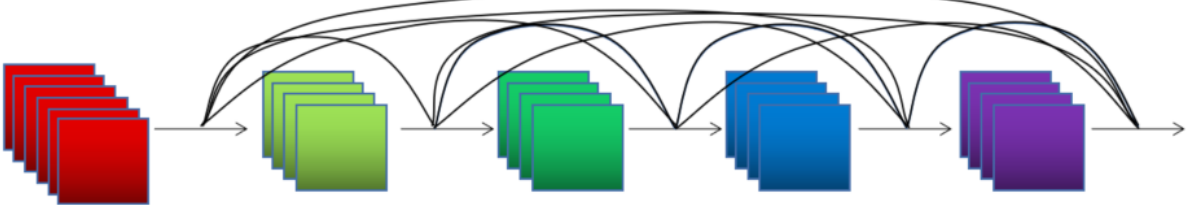
Figure 3. Structure of DenseNet for achieving maximum information flow during image recognition. Table 2. DenseNet-121 network structure.